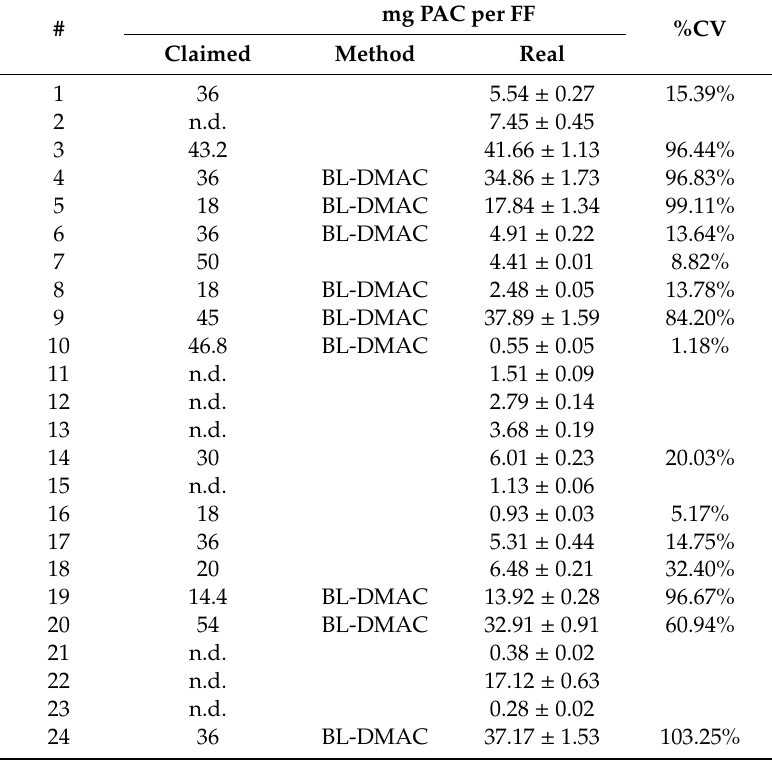
Table 2. Quantification of total proanthocyanidins content (tPACs) in the 24 Vaccinium macrocarpon -based dietary supplements by BL-DMAC assay. The column “method” reports the claimed analytical method used by the manufacturer for the quantification of tPACs. Results are expressed as mean of three di ff erent replicates ± SD, using external calibration curves of dimer PAC-A type. In the column “%CV”, the percentage di ff erences of tPACs between the value declared and that calculated via BL-DMAC assay are reported for each product. mg PAC per